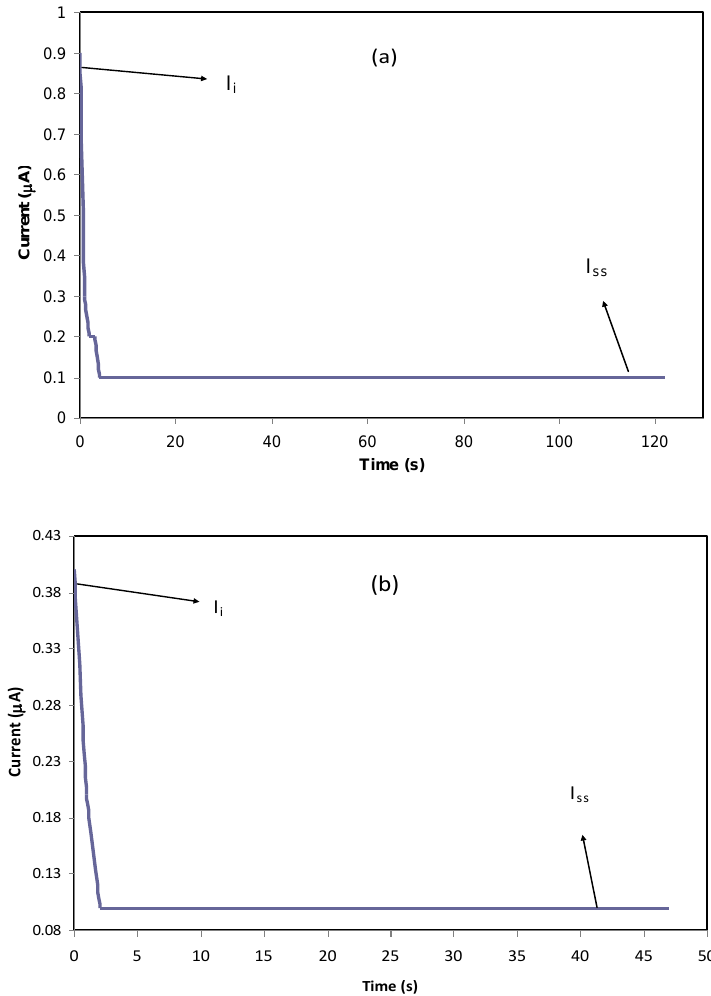
Figure 13. Polarization current versus time for ( a ) PVCS4 and ( b ) PVCS5 electrolyte films.